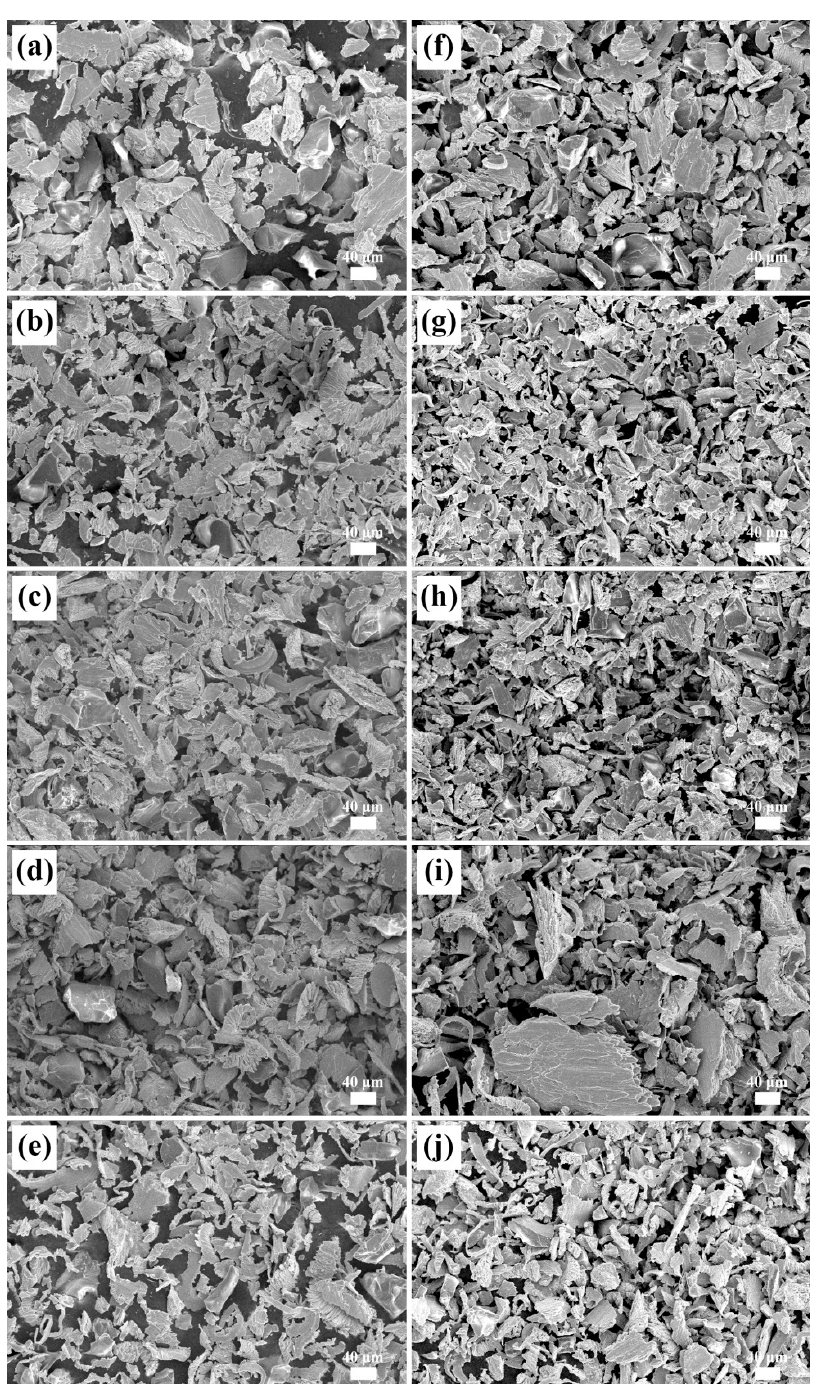
Figure 7. The ground particles of ( a , f ) cp-Ti; ( b , g ) Ti-5Al; ( c , h ) Ti-5Cr; ( d , i ) Ti-5Sn; ( e , j ) Ti-5V alloys ground using an SiC wheel at revolution speeds of 5000 rpm (left) and 10,000 rpm (right).